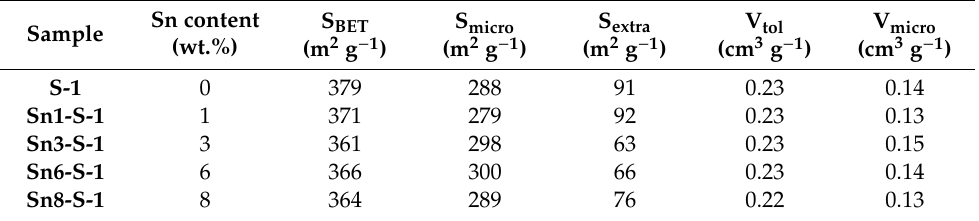
Figure 1. SEM images of Sn-containing defective S-1 (Snx-S-1) zeolite samples. Table 1. Textural properties of defective S-1 zeolite and its Sn-containing counterparts (Snx-S-1) .